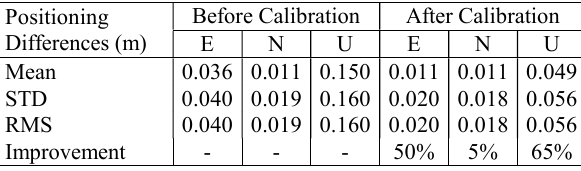
Table 4 . Statistical information of positioning differences before and after calibration with the proposed LiDAR navigation algorithm.